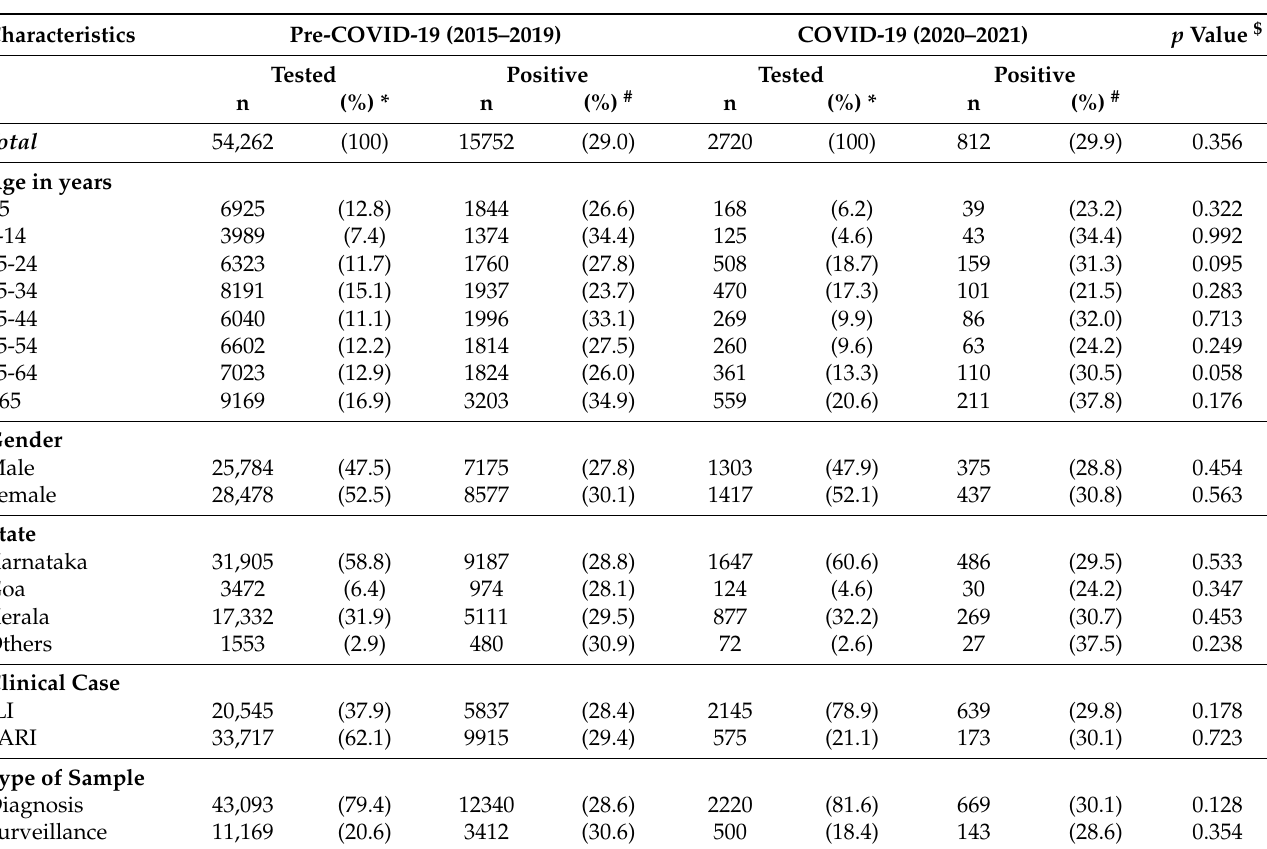
Table 2. Socio-demographic and clinical characteristics of the patients who were tested for influenza and test positivity rate at MIV, Karnataka during the pre-COVID-19 (2015 to 2019) and COVID-19 periods (2020 to 2021).